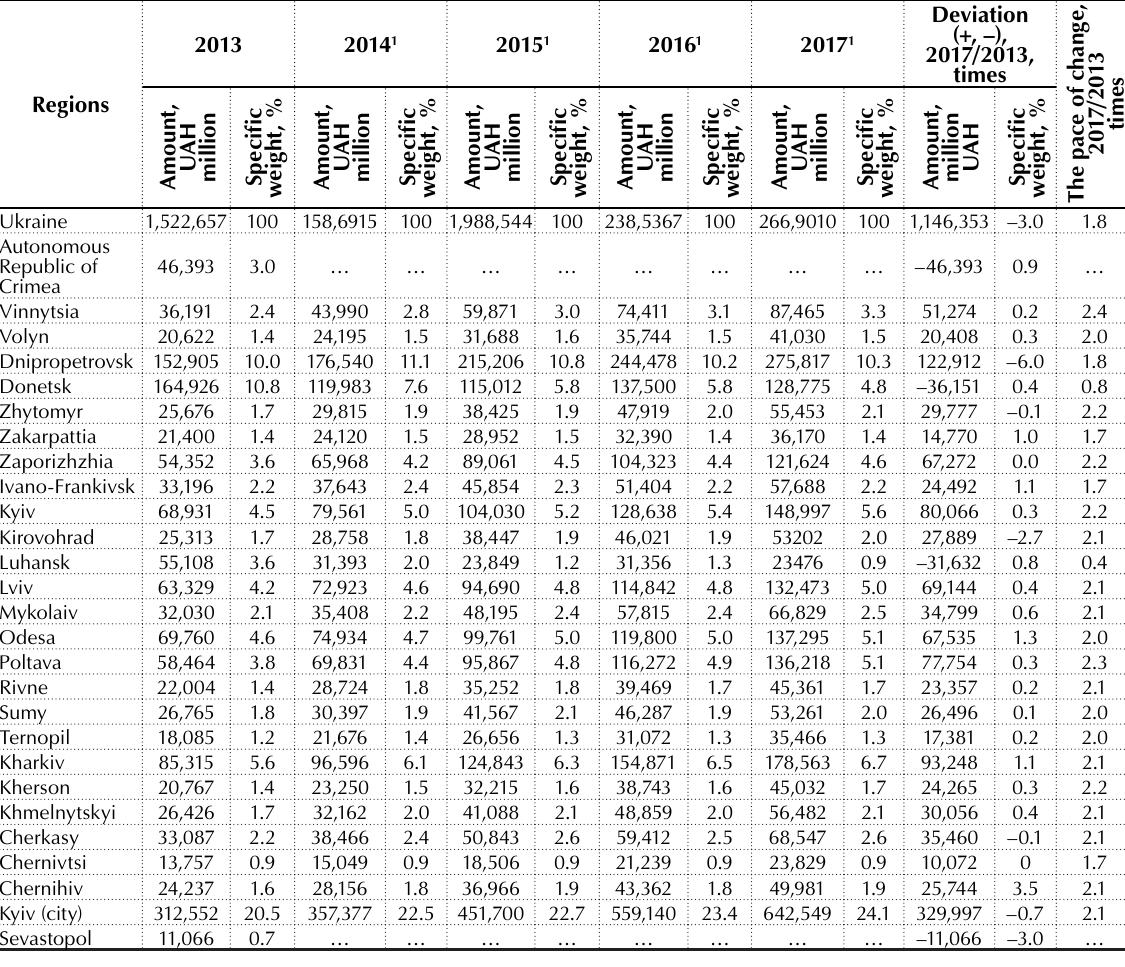
Table 1. Dynamics of the gross regional product of Ukraine and regions for 2013–2017 Source: Державна служба статистики України [Derzhavna sluzhba statystyky Ukrainy]